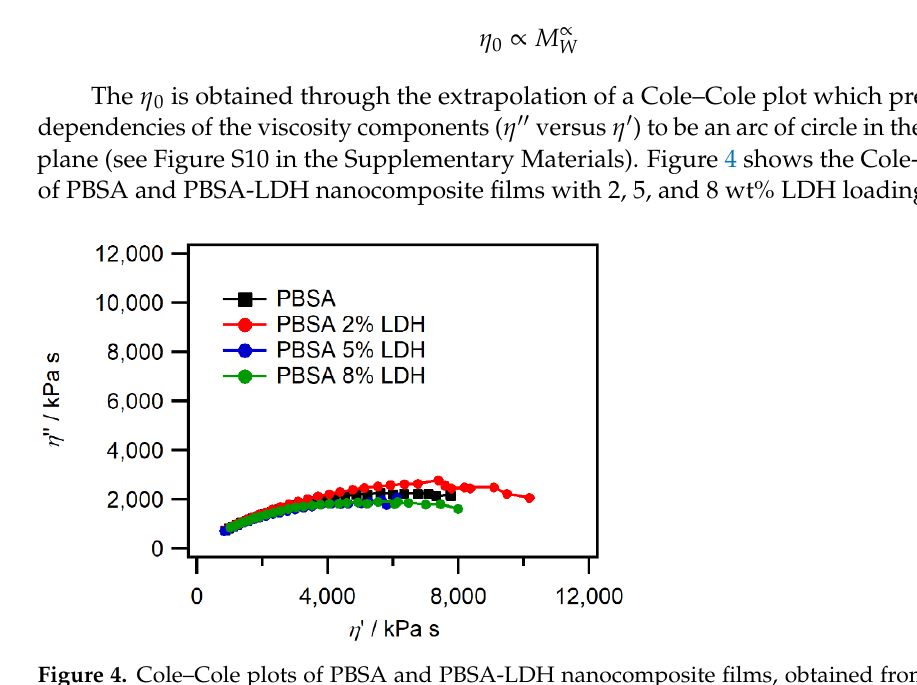
Figure 4. Cole–Cole plots of PBSA and PBSA-LDH nanocomposite films, obtained from melt viscoelastic rheology measurements conducted at 110 °C.